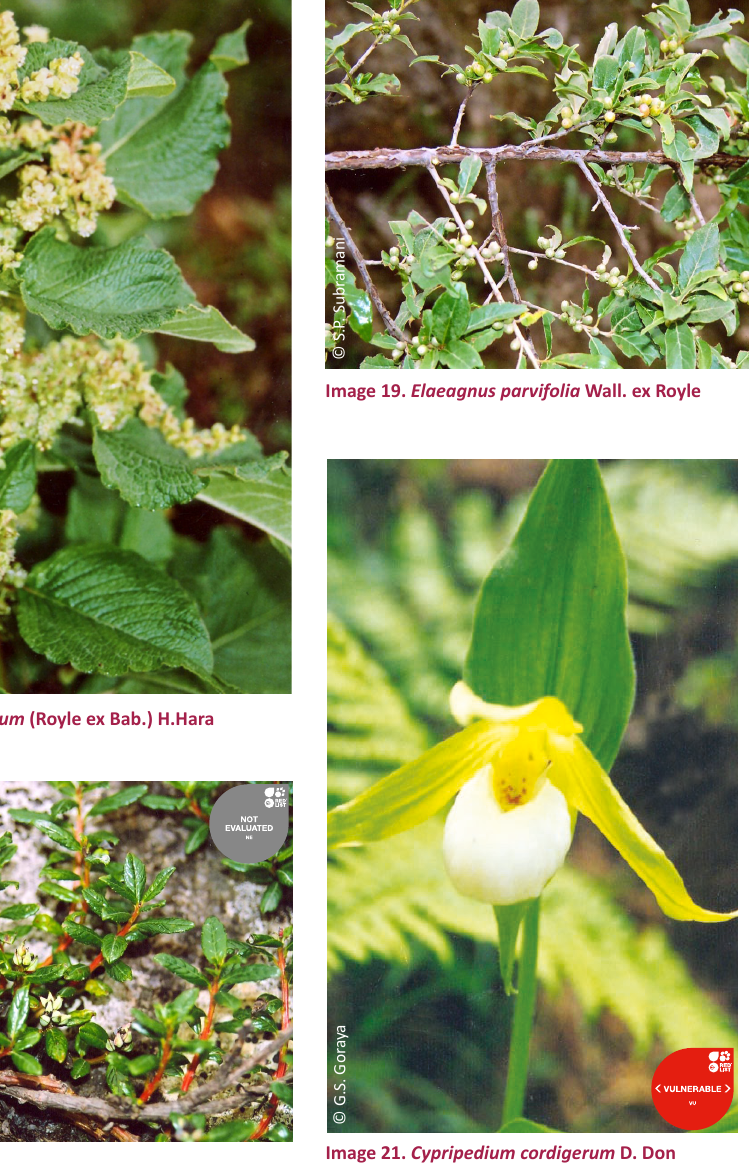
Image 20. Salix flagellaris Hultén